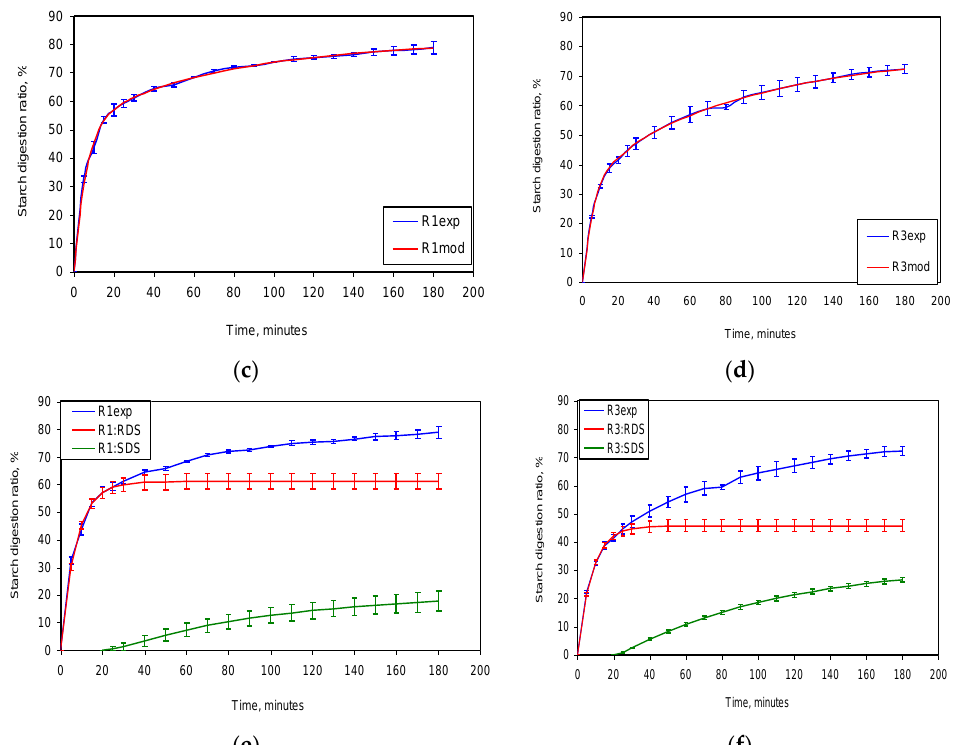
Figure 2. Application of LOS and NLLS kinetic models to the in vitro starch digestion results: RDS- rapidly digestible starch; SDS-slowly digestible starch; Total starch-the total amount of starch; R1exp and R3exp-experimental profiles for starch digestion ratio for R1 and R3 biscuits; R1mod and R3mod-modelled profiles for starch digestion ratio for R1 and R3 biscuits. ( a )-Experimental starch digestion profiles in reference biscuits (R1) and 15% yellow mealworm-biscuits (R3); ( b )-LOS method fit to the experimental results from the first replica of the starch digestion experiments in R1 biscuits, where line represents rapidly digestible starch fraction (RDS), red line represents slowly digestible starch fraction (SDS), and black line represents total starch digestion (overall fit curve); ( c )-comparative analysis between experimental and NLLS-modelled starch digestion profiles in ref- erence biscuits (R1); ( d )-comparative analysis between experimental and NLLS-modelled starch di- gestion profiles in 15% yellow mealworm biscuits (R3); ( e )-NLLS-modelled discrimination of total starch digestion profile in R1 biscuits between digestion profiles of RDS and SDS fractions; ( f )- NLLS-modelled discrimination of total starch digestion profile in R3 biscuits between digestion pro- files of RDS and SDS fractions. Table 5. The parameters associated with the four directions considered to characterise the first rep- lica of starch digestion in R1 biscuits, which were extracted from LOS mathematical model described in the Figure 2b.